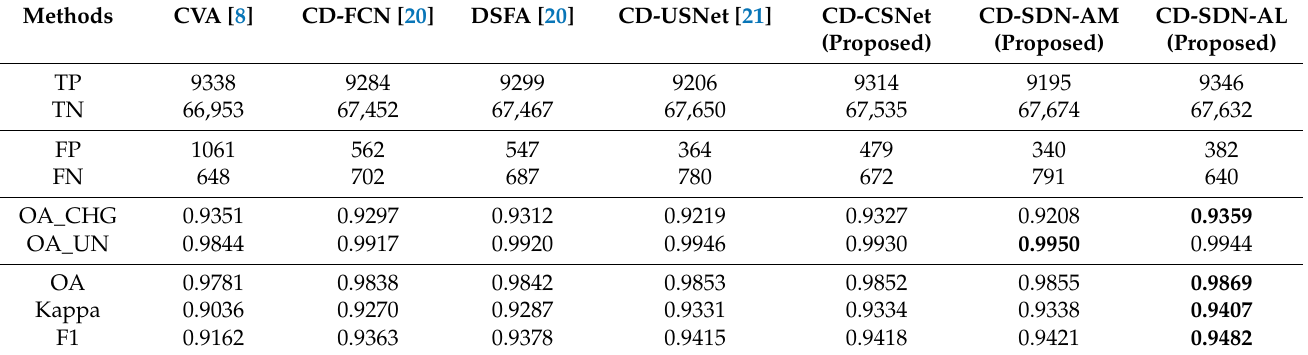
Table 2. The comparison of quantitative results on dataset ‘Hermiston’.